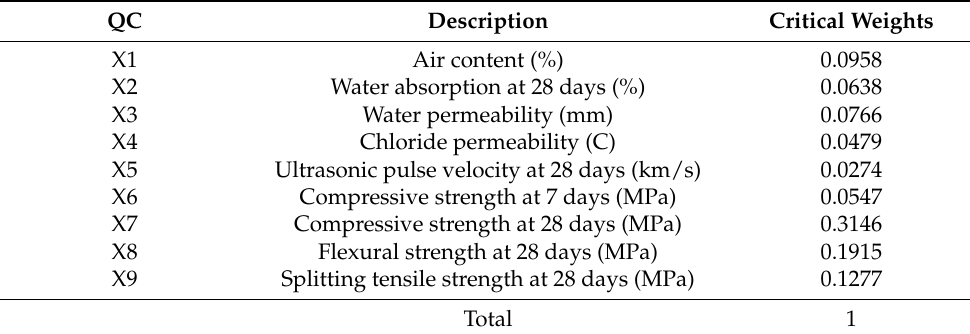
Table 5. Computed critical weights of QC.